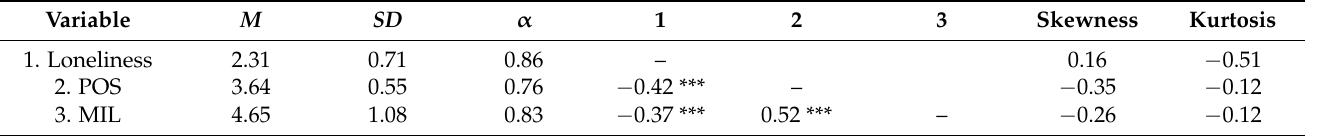
Table 1. Descriptive statistics, Cronbach’s alphas, and zero-order correlations between the variables.